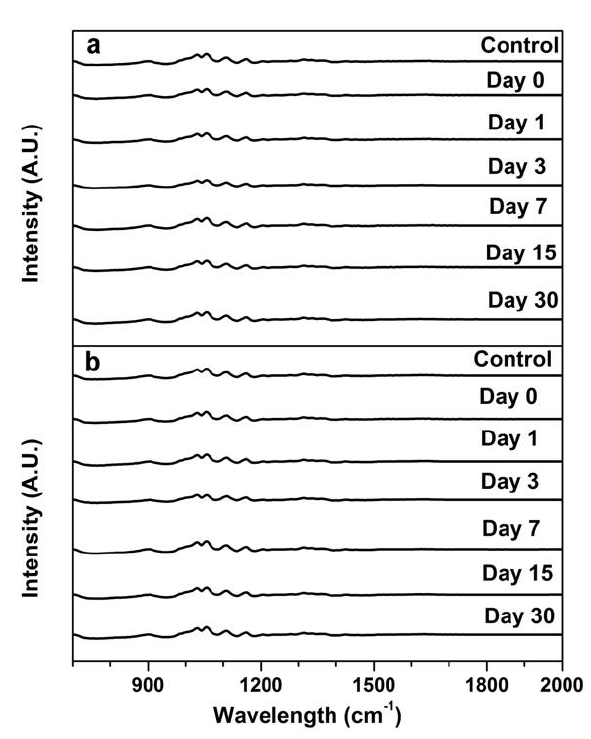
Figure A9. ATR-FTIR spectra of control ( a ) and plasma-treated ( b ) W 3 (cotton) in the range between 700 and 2000 cm − 1 .